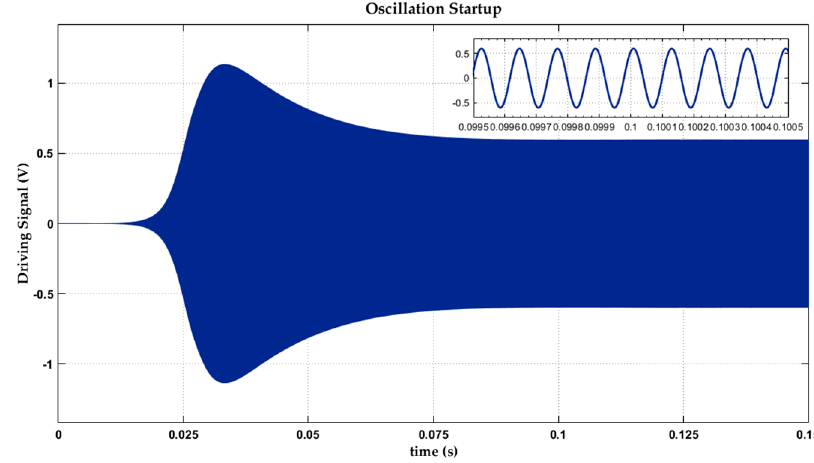
Figure 18. Start-up process of the closed drive loop.